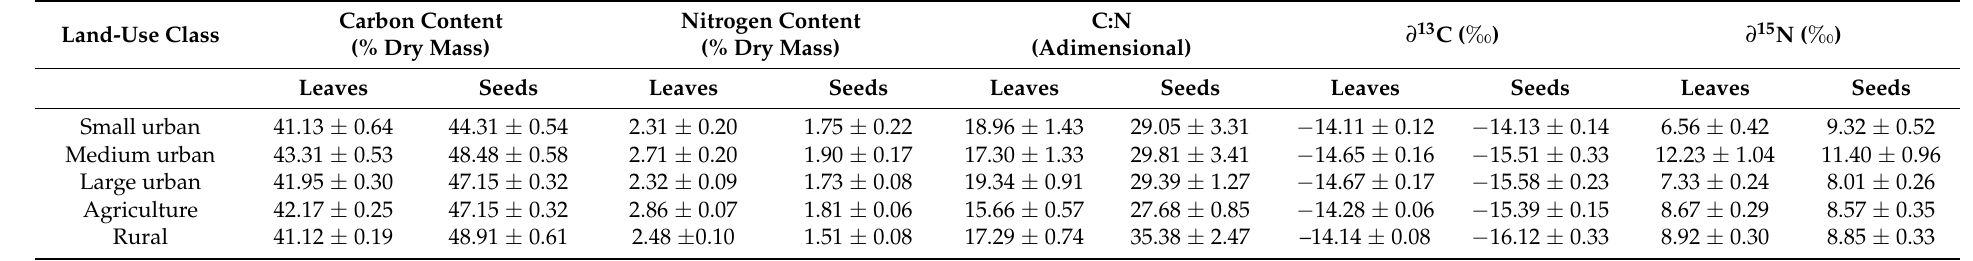
Table A1. Underlying data on the elemental and isotopic carbon and nitrogen status for leaves and seeds of C. ciliaris collected from sites with different land